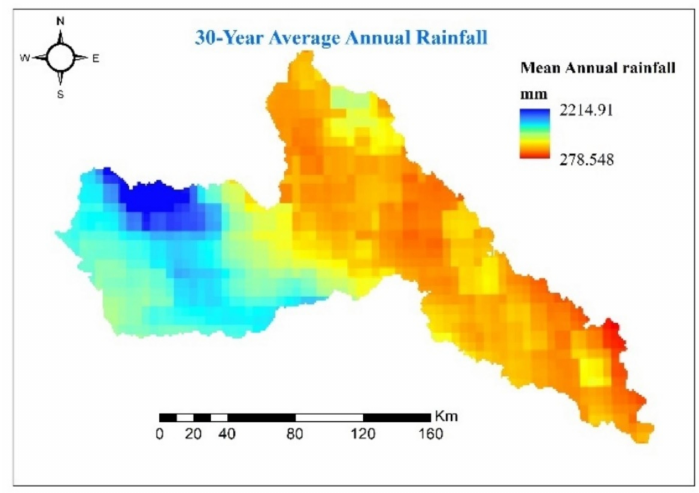
Figure 2. The 30-year average annual rainfall of the Chenab river catchment.